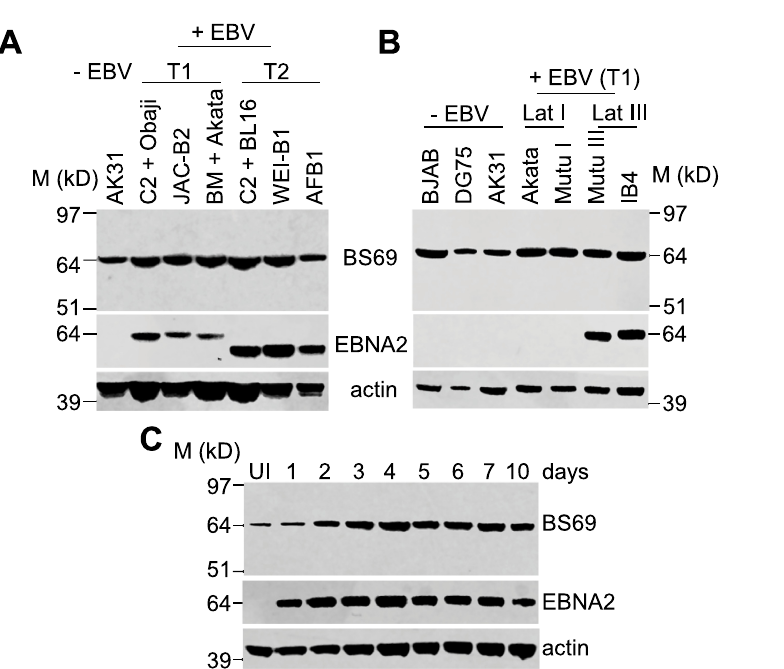
Fig 8. Western blot analysis of BS69 expression in EBV infected B cells. (A) Western blot analysis of BS69 expression in the EBV negative BL cell line AK31 and type 1 and type 2 EBV immortalised LCLs (that display the latency III pattern of gene expression associated with expression of all EBV latent proteins). BS69 was detected using an antibody that recognises a sequence in the MYND domain encoded by exon 15 (ab190890). EBNA2 was detected using the PE2 monoclonal antibody. Type 2 EBV has a lower molecular weight due a difference in the number of proline repeat residues present. Blots were probed for actin as a loading control. (B) Western blot analysis of BS69 expression in EBV negative (BJAB, DG75, AK31) and EBV positive latency I (Akata and Mutu I) and latency III B cell lines (Mutu III (BL) and IB4 (LCL) as in A. (C) Western blot analysis of BS69 expression on primary B cell infection. UI indicates uninfected primary B cells. Samples were taken at the indicated day post-infection and analysed as in